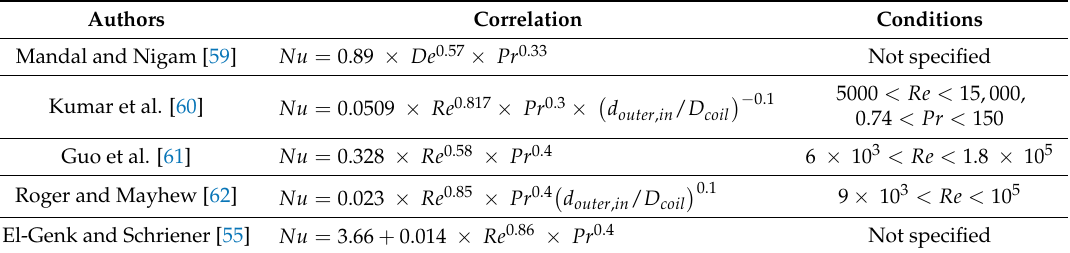
Table 3. Correlations used to determine the outer Nusselt number.